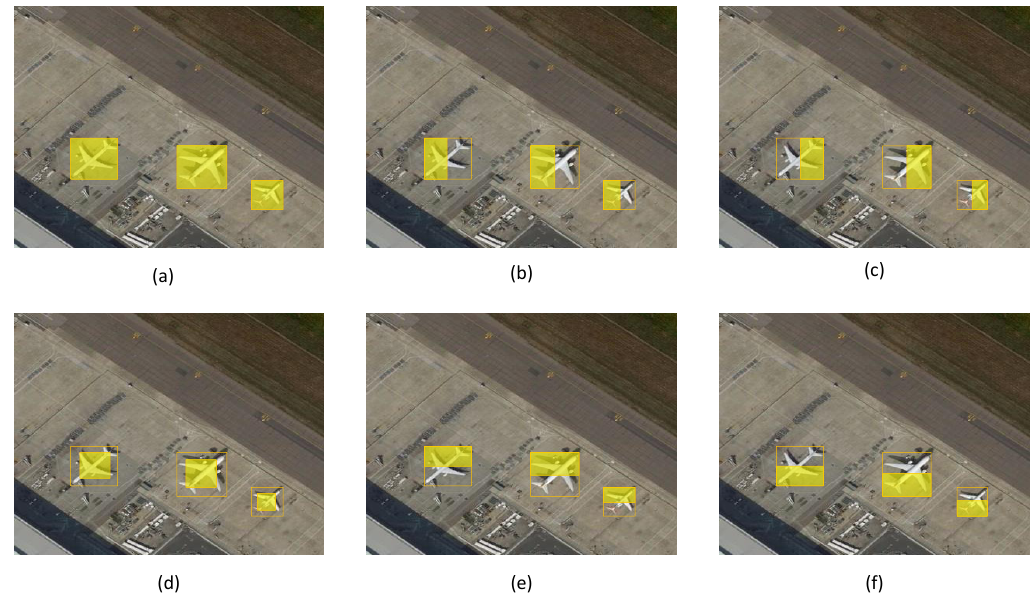
Figure 5. Illustration of object parts used in the proposed framework. ( a ) Original candidate boxes. ( b ) Left-half part of candidate boxes. ( c ) Right-half part of candidate boxes. ( d ) Inner part obtained by scaling candidate boxes by a factor of 0.7. ( e ) Up-half part of candidate boxes. ( f ) Bottom-half part of candidate